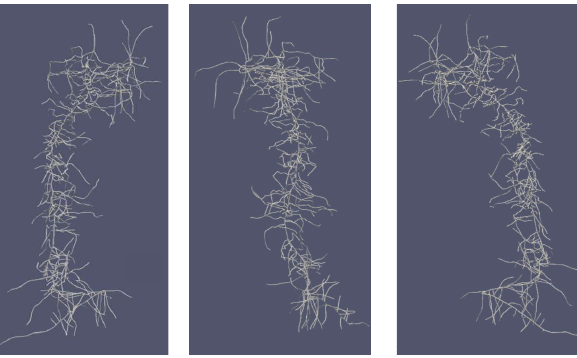
Figure 18. Front-view, left-view, and right-view of the root reconstruction system .